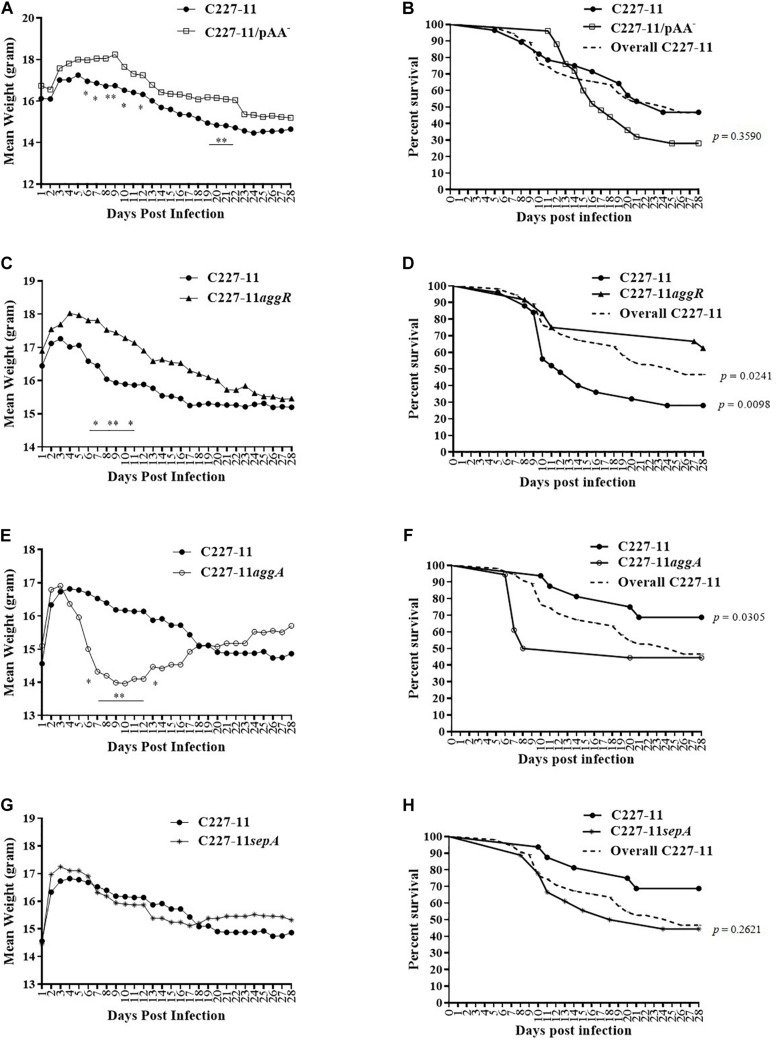
Mean weight change in grams and percent survival over time of Amp-treated C57BL/6 mice orally infected with either C227-11 () or C227-11/pAA– () (A,B), C227-11 () or C227-11aggR () (C,D), C227-11 () or C227-11aggA() (E,F) or C227-11 () and C227-11sepA(*) (G,H). Points on the graph represent the actual mean weight in grams from day one (D-1) of two or three separate experiments. Combined, 126 mice were included: 42 received C227-11, 25 C227-11/pAA–, 24 C227-11aggR, 18 C227-11aggA, and 17 C227-11sepA. The dashed line (Overall C227-11) represents all mice infected with C227-11 over the course of all animal studies included in the analysis. Differences between groups were determined by ANOVA multiple comparison with uncorrected Fisher’s least significant difference (LSD); asterisks indicate days on which a significant difference between mean weights was observed. *p < 0.05 and ∗∗p < 0.005. For panels (B,D,F,H) differences between groups were determined by comparison of survival curves with the Log-rank (Mantel-Cox) test. The exact p-Values are shown on the figure.